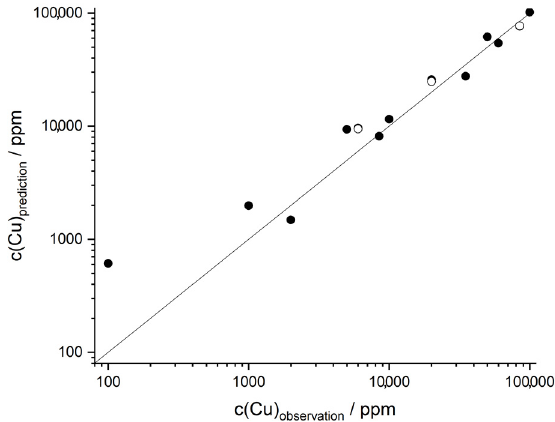
Figure 5. PLSR of CuFeS 2 data in basalt at Echelle spectrometer with 2 components after elimination of outliers, black dots represent calibration model (R 2 CV = 0.98, RMSECV = 4880 ppm), circles represent validation (R 2 V = 0.96, RMSEV = 4586